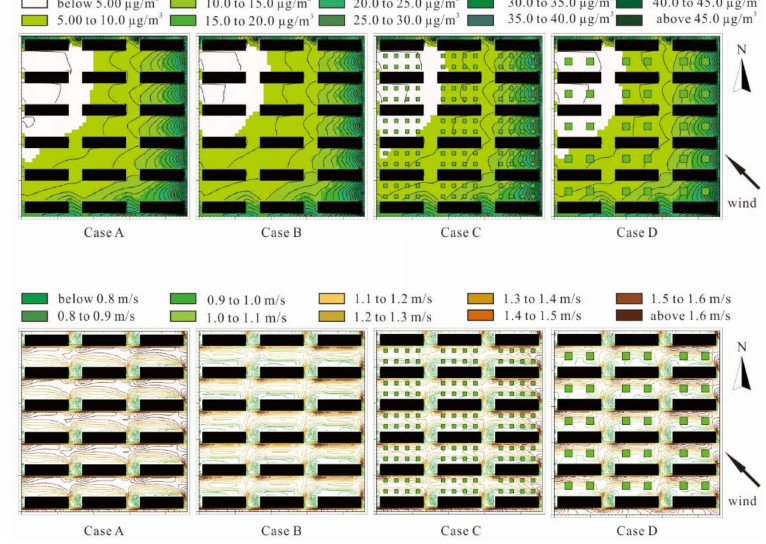
Figure 15. Contours of PM10 concentration ( top ) and wind speed ( bottom ) in the residential area at pedestrian height on 23 June at